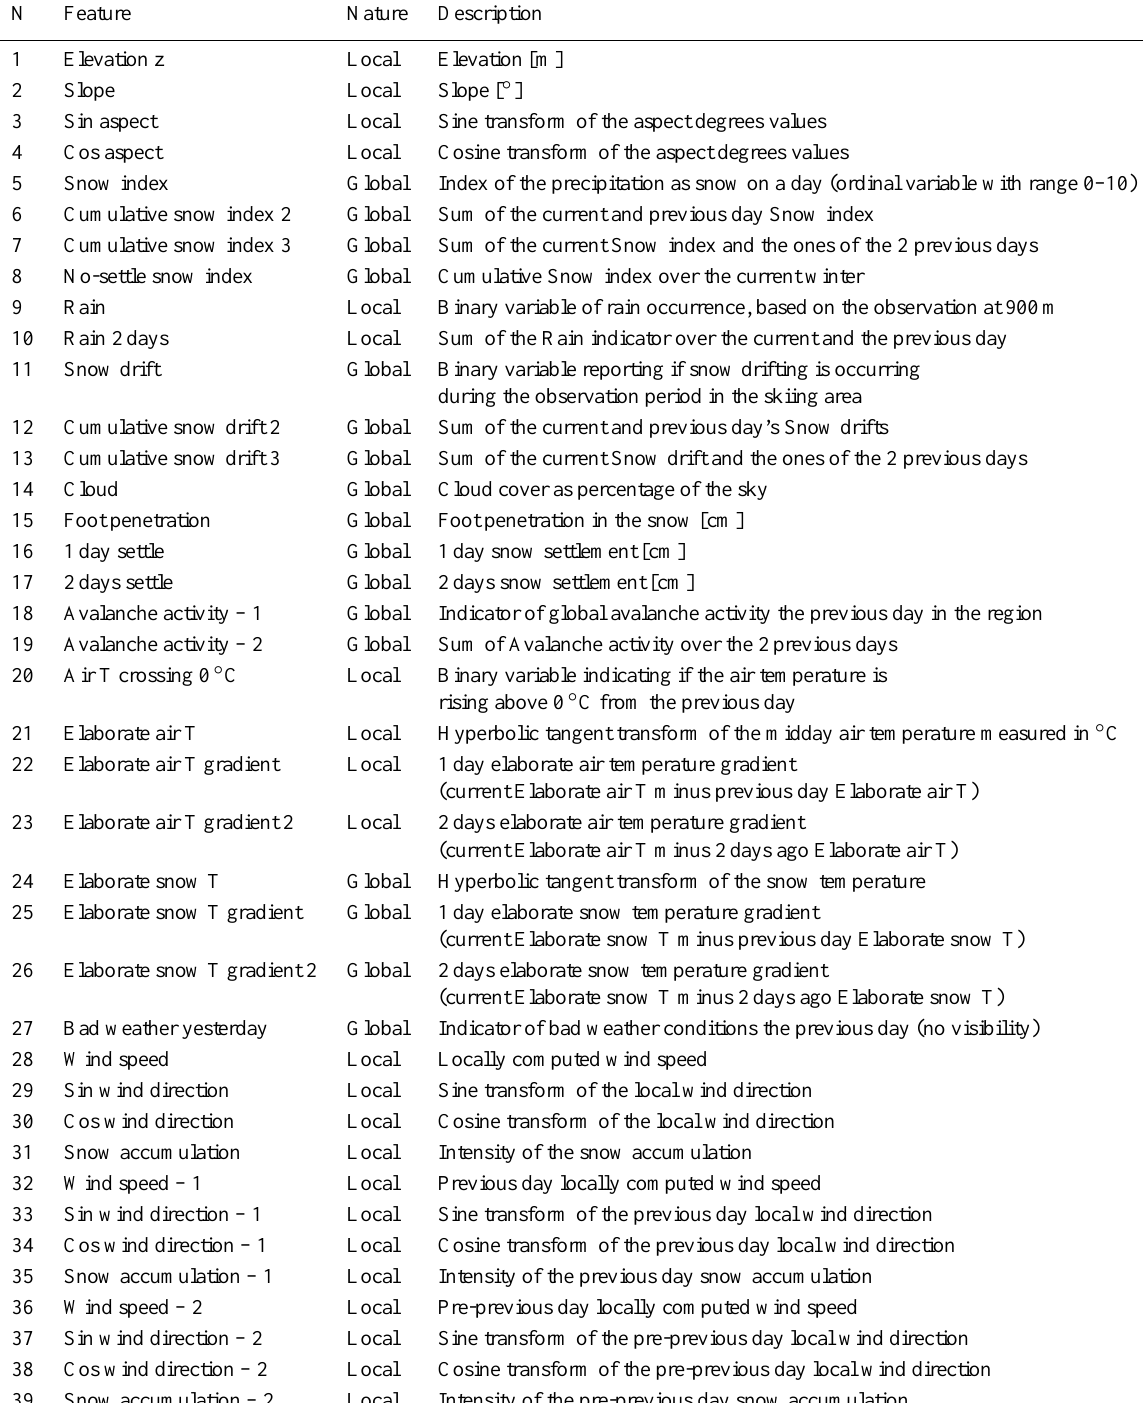
Table 3. List of the 39 input features